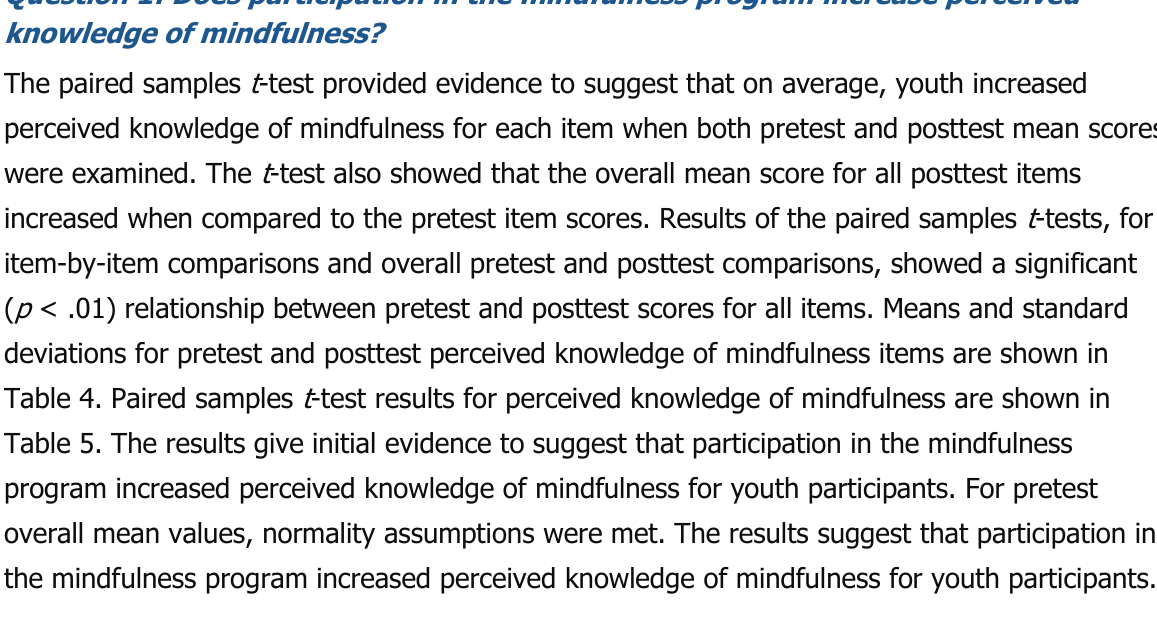
Table 4. Means and Standard Deviations for Pretest and Posttest